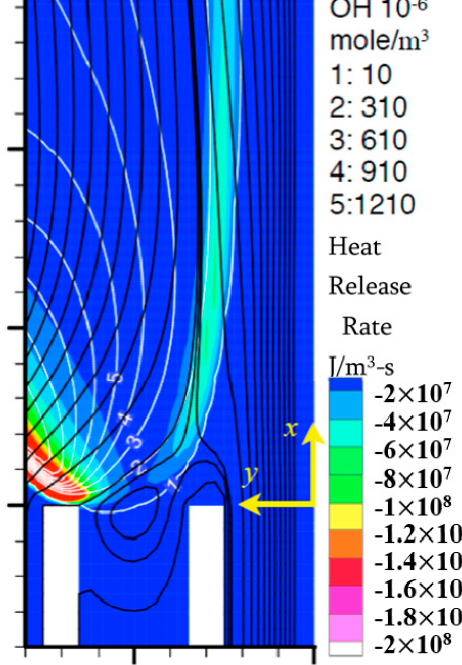
Figure 8. OH isopleths in white and streamlines in black in the post-flame region in contrast to the color-coded heat release rate distribution. The burning conditions were for the center flame at φ = 0.5 and outer flame at φ = 0.88. The average jet exit speed was equal to 1 m/s for both center and outer flames.